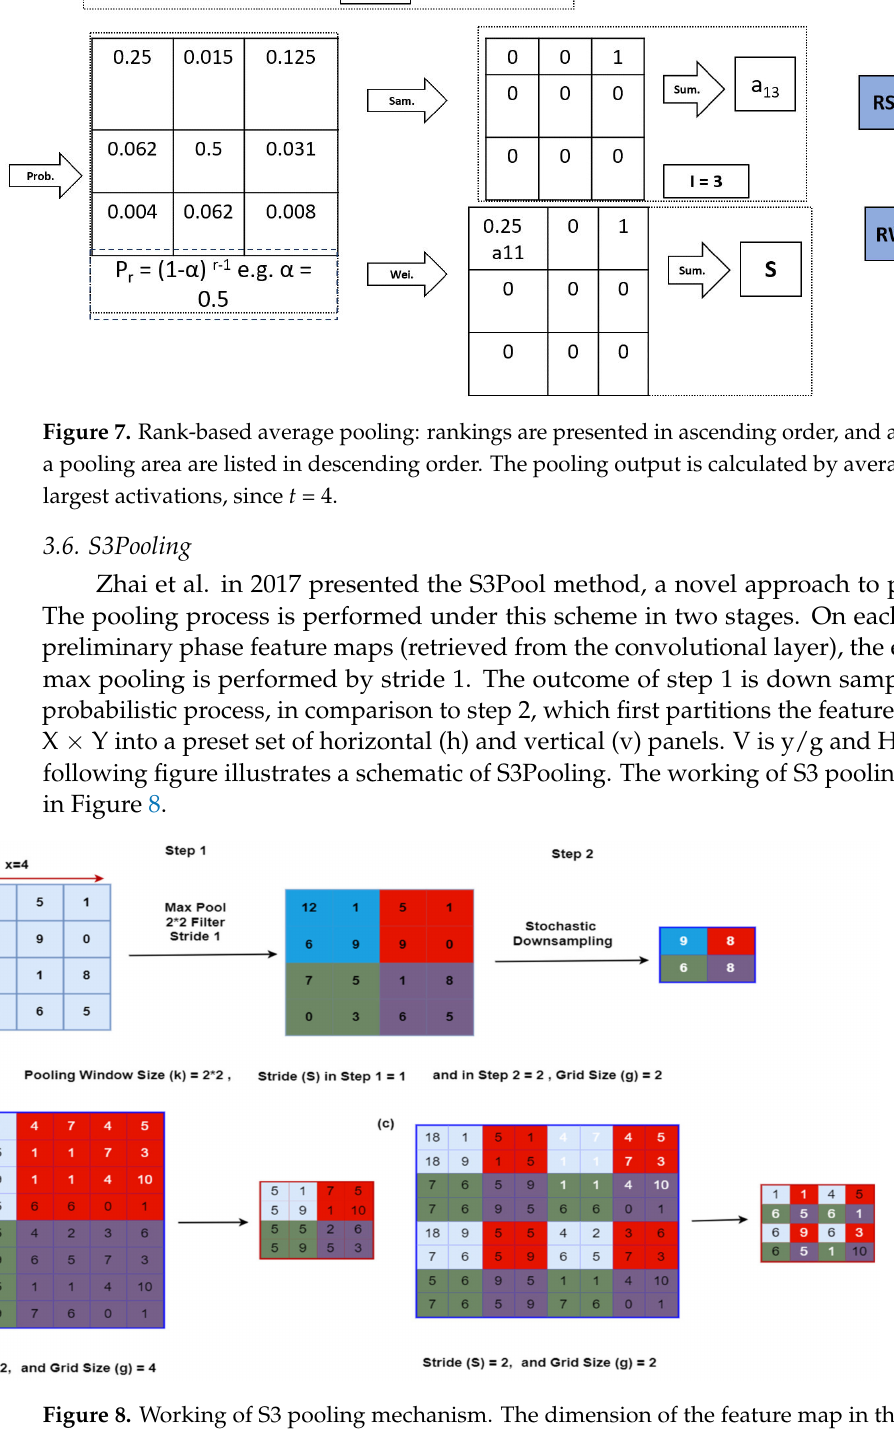
Figure 8. Working of S3 pooling mechanism. The dimension of the feature map in this example is 4 × 4, with both x and y = 4 represented in ( a ). The max pooling operation in step 1 uses stride 1, and there is no padding at the border. The grid size and stride should both be 2 in step 2. There will be two horizontal (h) and vertical (v) strips. In step 2, a stochastic downsampling is used to represent the rows and columns that were randomly chosen to build the feature map. Flexibility to change the grid size in step 2 in order to control the distortion or stochasticity is represented in ( b , c